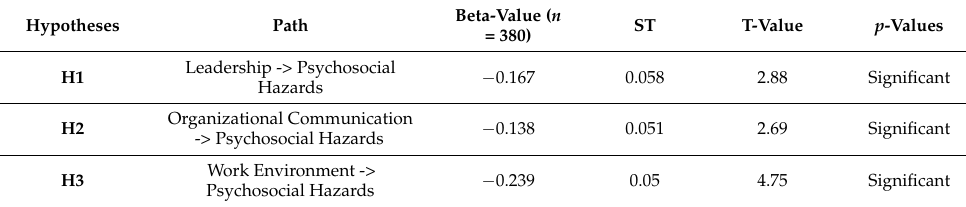
Table 6. Hypothesized testing